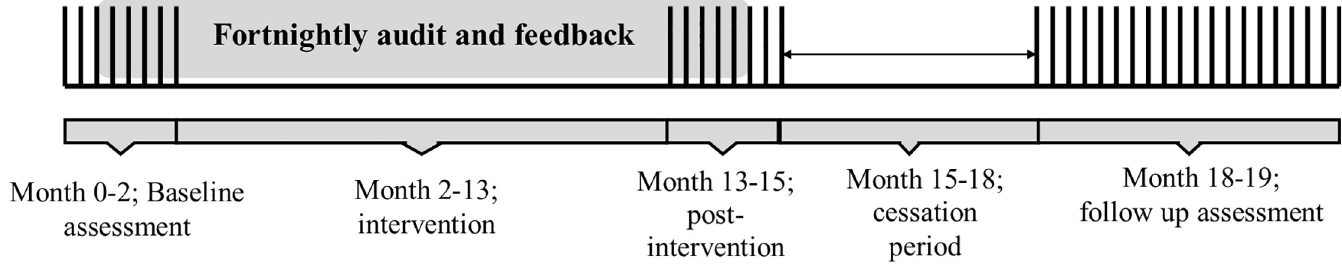
Fig 1. Design and flow of the study.